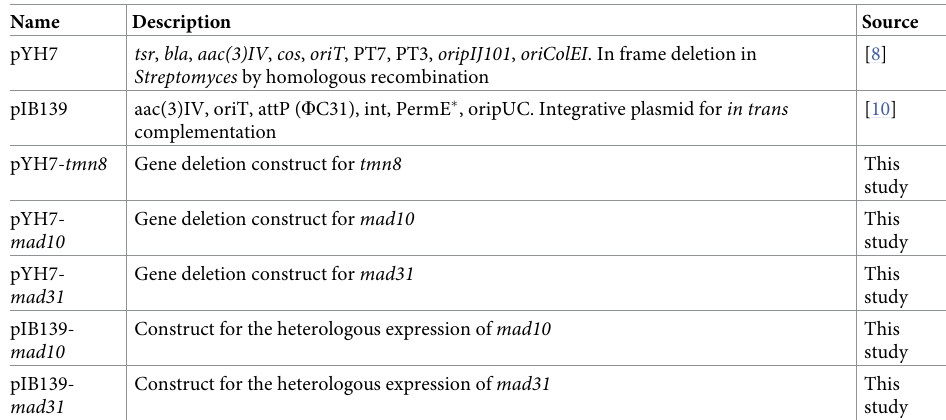
Table 2. Plasmids used in this